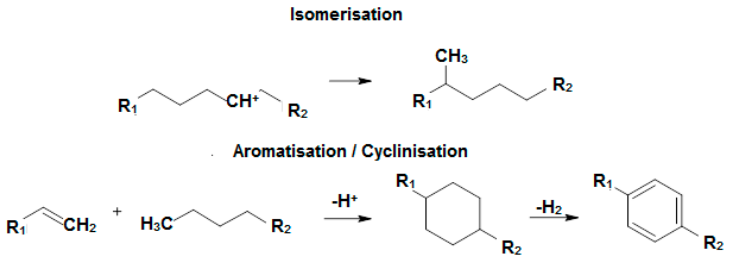
Figure 6. Isomerization, cyclization and aromatization pathway (data published in accordance, with permission from Elsevier[19]).